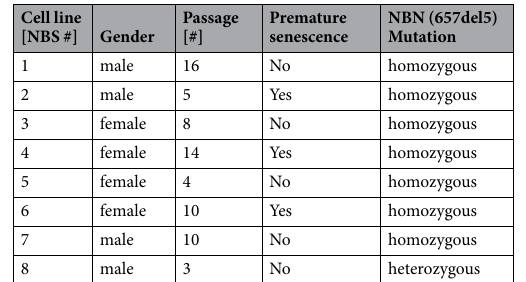
Table 1. Fibroblasts lines from NBS patients and their behavior in reprogramming. n/a: not available; #: number.